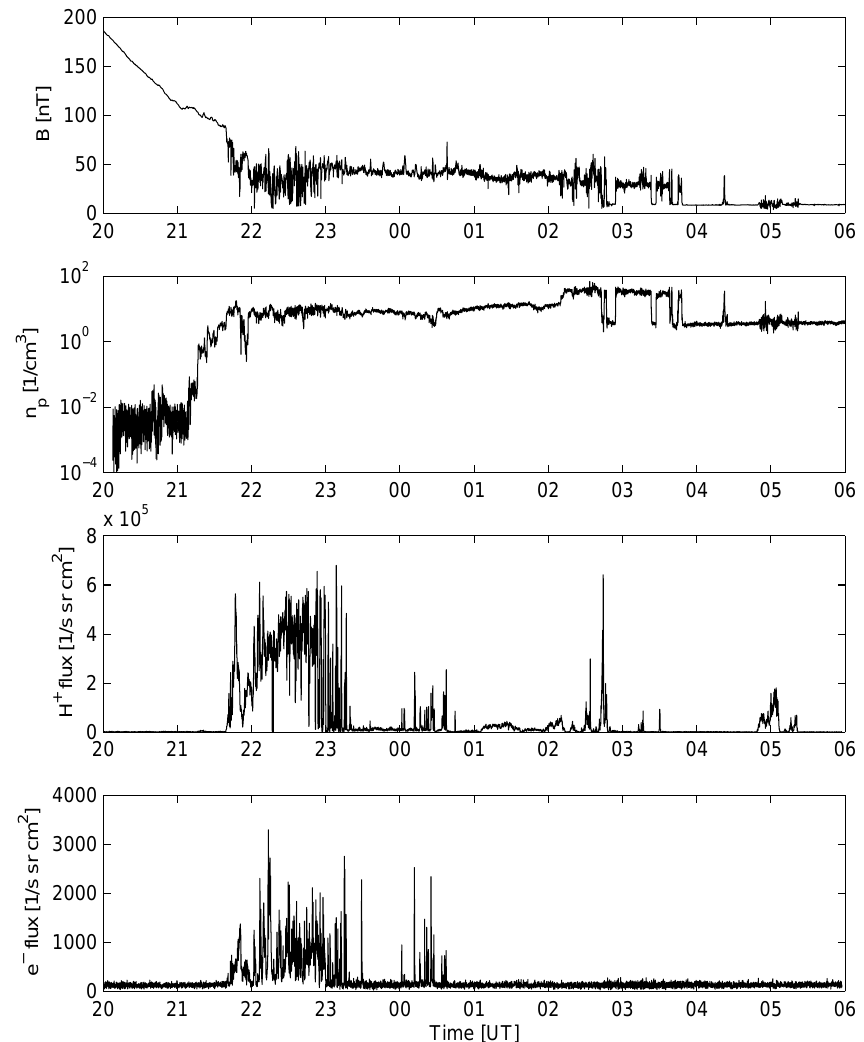
Fig. 1. Overview of Cluster 4 data on 2–3 February 2003. Panels from top to bottom depict the magnetic field intensity, plasma proton density, and the total fluxes of energetic protons and electrons measured by the RAPID